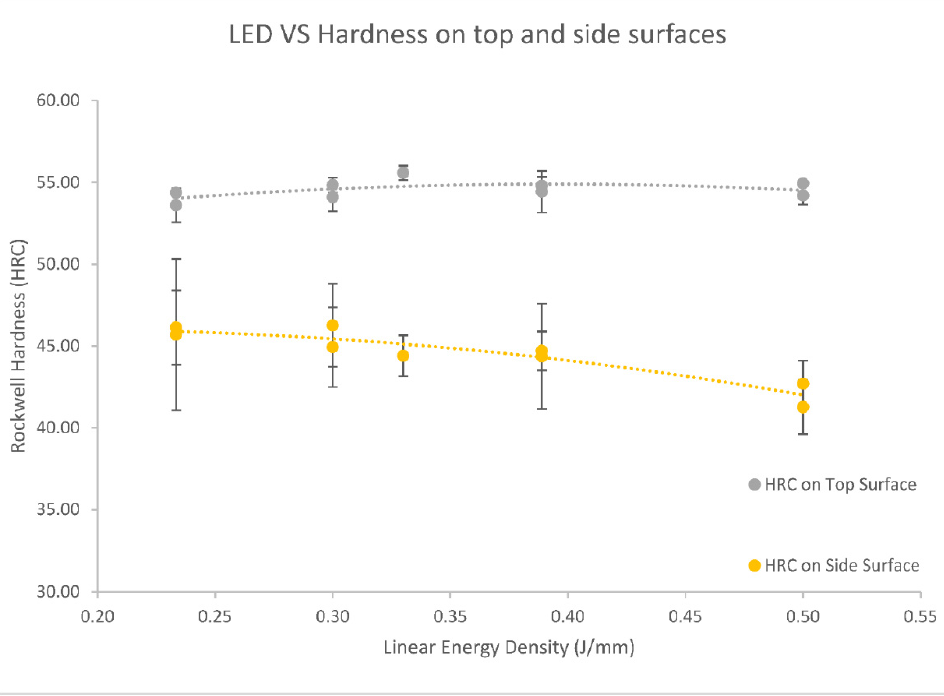
Figure 12. Measured Rockwell hardness HRC on the top and side surfaces.